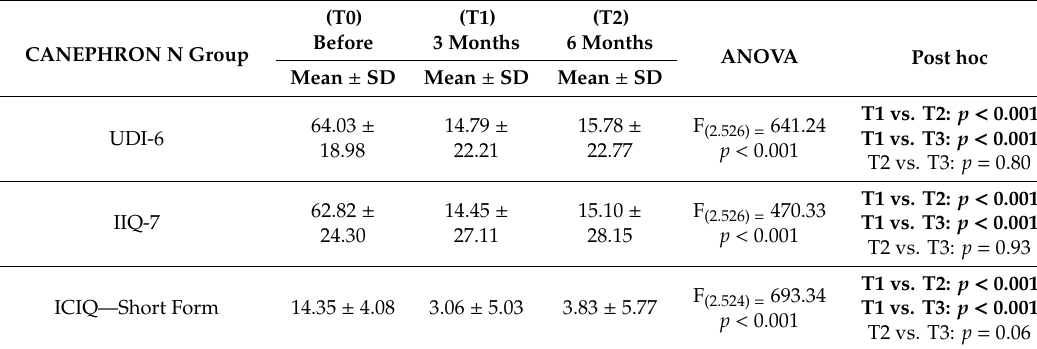
Table 2. The influence of TOT surgery on the results of ICIQ-SF, UDI-6, and IIQ-7 questionnaires in patients receiving Canephron N.